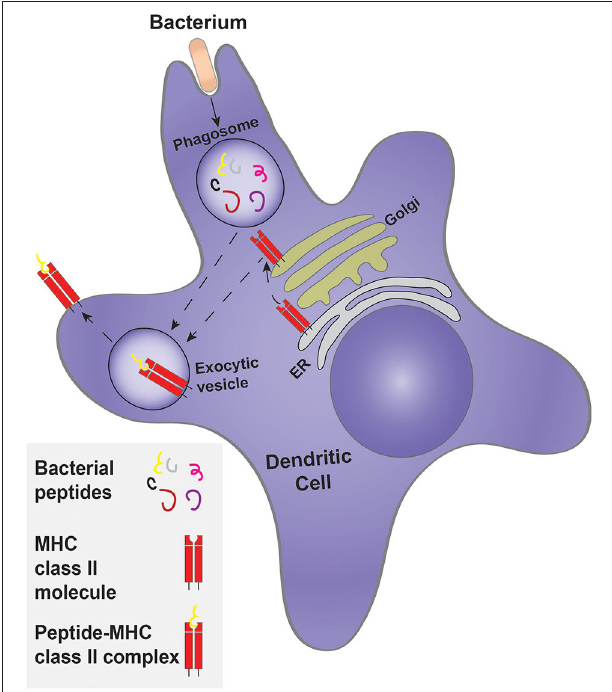
FIGURE 5 | Classical antigen presentation by a dendritic cell. Dendritic cells engulf a target, such as bacteria, forming a phagosome. Controlled bacterial degradation in the phagosome generates peptides that are used for antigen presentation on MHC class II molecules. The MHC class II molecule is synthesized and processed by the ER and Golgi complex, being delivered to an exocytosis-competent vesicle where it encounters and is loaded with antigenic peptides to form the peptide-MHC class II